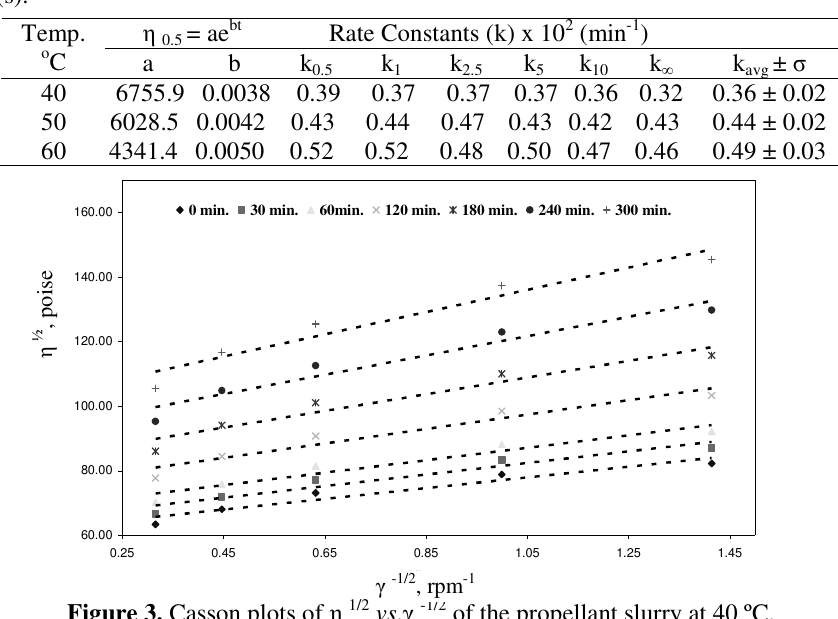
Figure 3. Casson plots of η 1/2 vs . γ -1/2 of the propellant slurry at 40